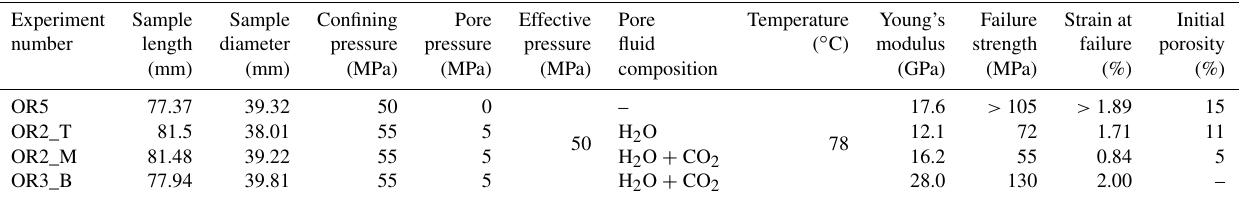
Figure 1. Backscattered electron (BSE) images of the starting material. Location of higher-magnification images is shown by yellow rectan- gles. (a) Representative sample microstructure; the glassy matrix shows a range of crystal content and habitat and is locally altered; the area where energy dispersive spectroscopy (EDS) analysis is conducted (see details in Fig. A1) is marked by the dashed rectangle. (b) Another common glassy matrix microstructure with finer, more homogenous crystals. (c) Detail of altered matrix and pore wall. Note the black voids in the shape of subhedral feldspar laths in the matrix. (d) Detail of patchy phyllosilicate alteration and dendritic crystals in altered matrix. (e) High-magnification image of dendritic crystals forming the matrix and phyllosilicate coating of the pore wall. (f) High-magnification image of glassy matrix with homogenous small crystals. (g) High-magnification image of dendritic crystals forming the unaltered matrix and high-magnification image of the phyllosilicate alteration. Table 1. Details of the sample parameters and experimental conditions. Sample OR5 was not loaded to its failure strength due to early failure of the strain gauges and LVDTs. Porosity is estimated from the X-ray tomographic image of the sample. Initial porosity of the sample OR3_B is not available due to limited access to the X-ray tomography facility during the COVID-19